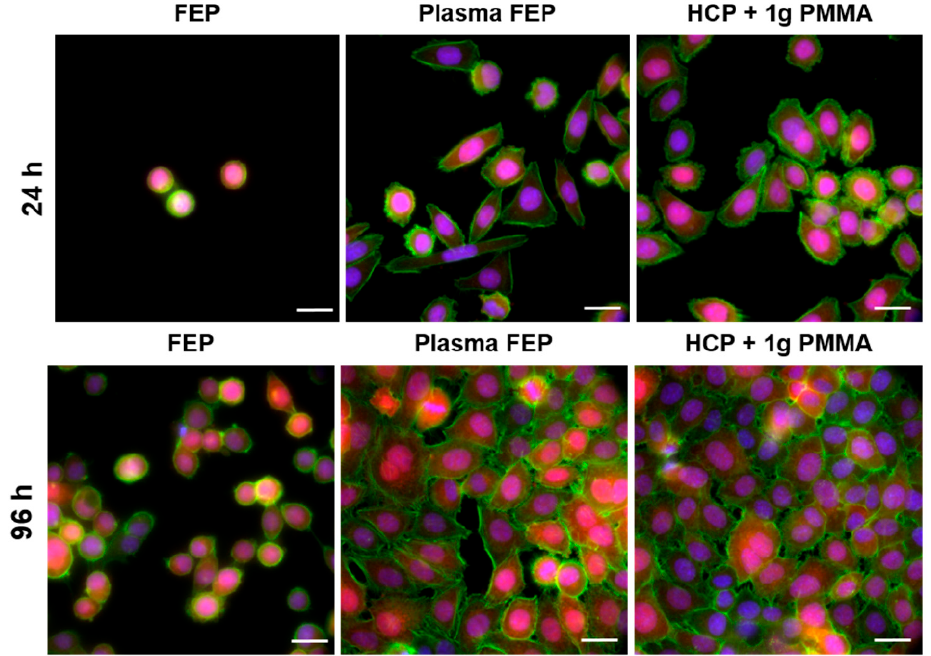
Figure 9. Fluorescence microscopy images of VAMPIRO U-2 OS cells (human cells derived from osteosarcoma, stably transfected with tFP602) growing on pristine fluorinated ethylene propylene (FEP) and FEP treated with 8 W plasma for 240 s and subsequently coated with a honeycomb-like pattern formed from polymethyl methacrylate (PMMA) solution (1 g), 24 h and 96 h post-seeding, respectively. Scale bar represents 20 microns [24].